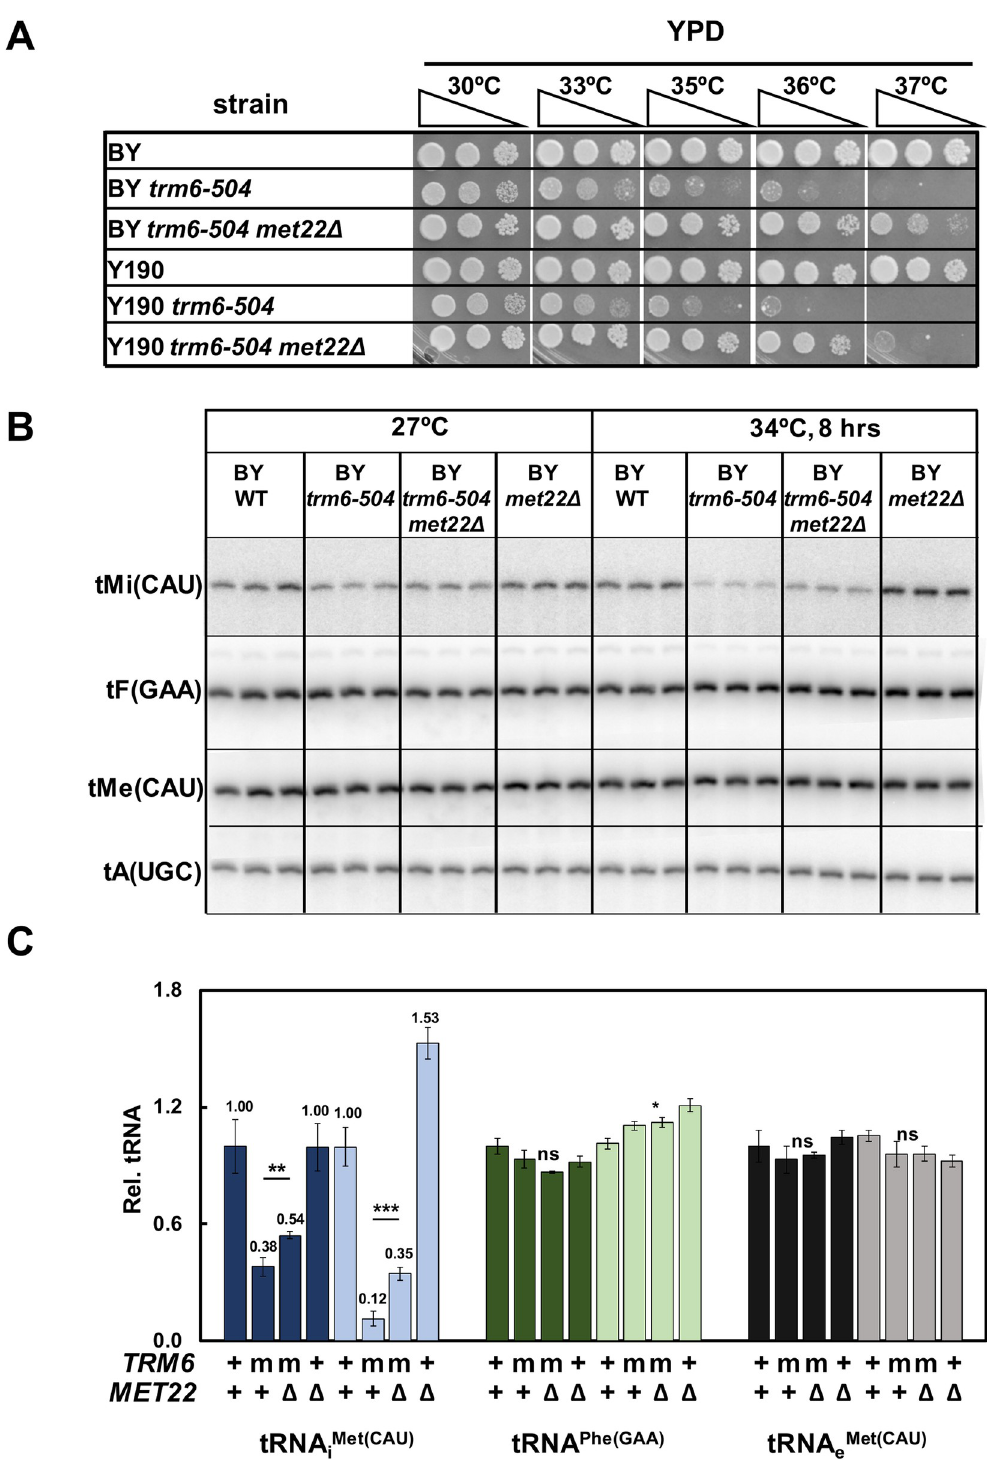
Fig 6. The temperature sensitivity and reduced tRNA i Met(CAU) levels in S . cerevisiae trm6-504 mutants are suppressed by a met22 Δ mutation. (A) A met22 Δ mutation substantially suppresses the S . cerevisiae trm6-504 temperature sensitivity. Strains were grown overnight in YPD media at 30˚C and analyzed for growth on indicated plates and temperatures. BY; standard BY4741 WT strain background; Y190, background of original trm6-504 mutant (B) A met22 Δ mutation substantially restores tRNA iMet(CAU) levels in S . cerevisiae trm6-504 mutants. Strains were grown in